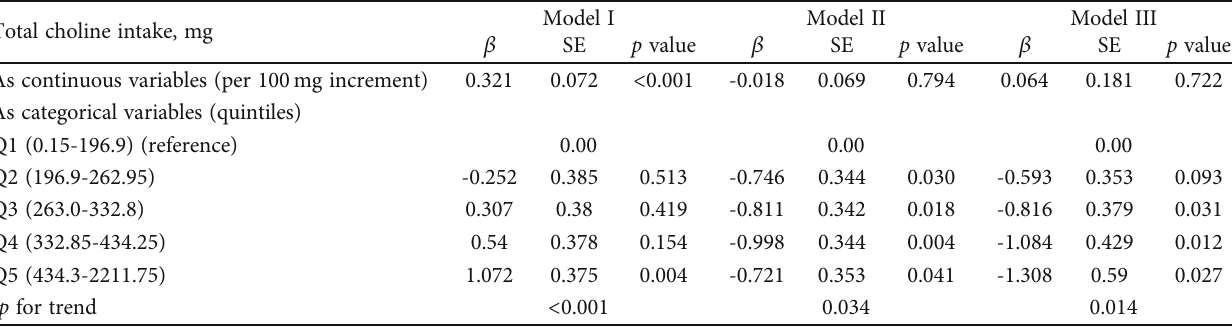
Table 3: Linear regression of total choline with systolic blood pressure after excluding patients using antihypertensive drug ( n = 17296 ). Total choline intake,